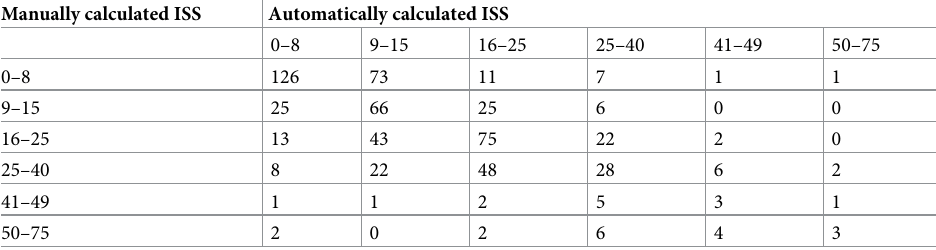
Table 3. Cross-tabulation of the automatically and manually calculated ISS. Manually calculated ISS Automatically calculated ISS